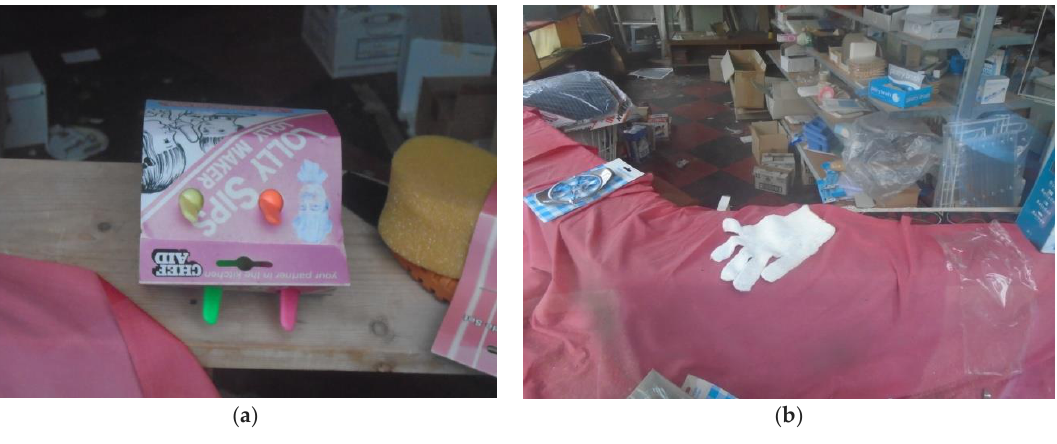
Figure 30. ( a ) Lollipop makers; ( b ) White glove.